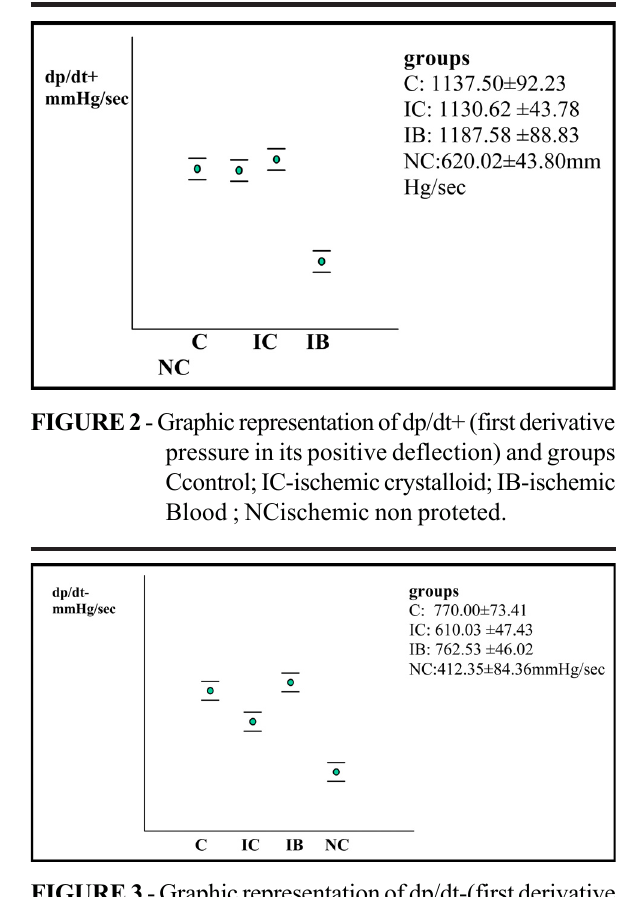
FIGURE 3 - Graphic representation of dp/dt-(first derivative pressure in its negative deflection) and groups C-control; IC-ischemic crystalloid; IB-ischemic Blood ; NC-ischemic non proteted